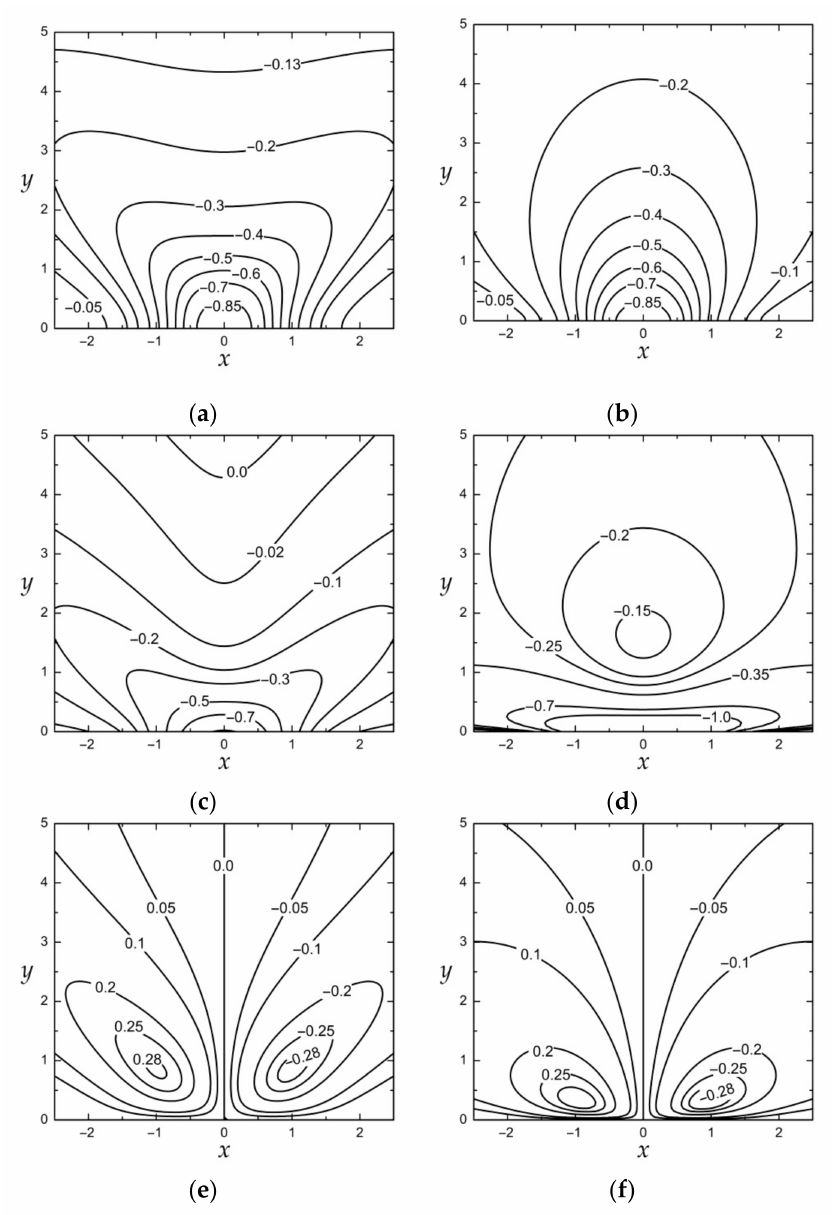
Figure 2. The full-field distributions of the dimensionless stress tensor components for the or- thotropic composite materials with properties given in Table 1 under the normal force loading p ( x ) = p 0 exp ( − κ x 2 ) at κ = 1 : ( a ) σ yy / p 0 for material 1 , ( b ) σ yy / p 0 for material 2 , ( c ) σ xx / p 0 for material 1 , ( d ) σ xx / p 0 for material 2 , ( e ) σ xy / p 0 for material 1 , ( f ) σ xy / p 0 for material 2